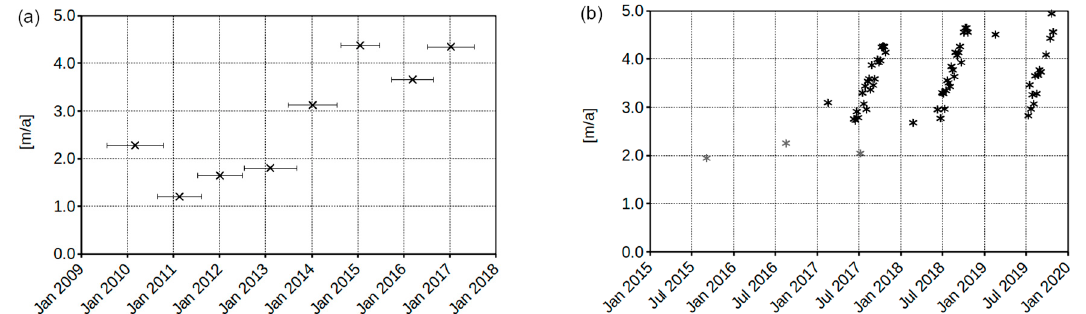
tracking from 27.08.2010 to 14.08.2011; ( c ) Cosmo-SkyMed interferogram from 15.09.2017 to 24.09.2017, 2 π ⇔ 1.6 cm; ( d ) Sentinel-1 interferogram from 24.09.2017 to 30.09.2017, 2 π ⇔ 2.8 cm. The black arrow indicates the satellite line-of-sight.